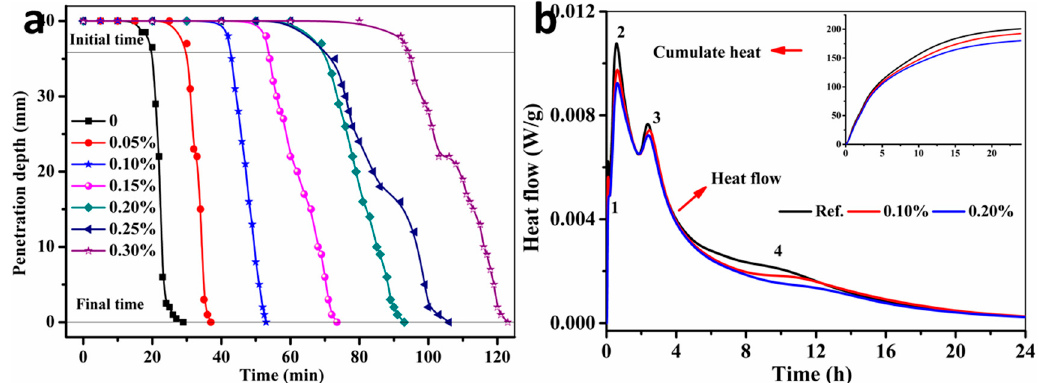
Figure 4. ( a ) The setting time and ( b ) hydration heat of the SAC paste with different additions of tartaric acid (TA).